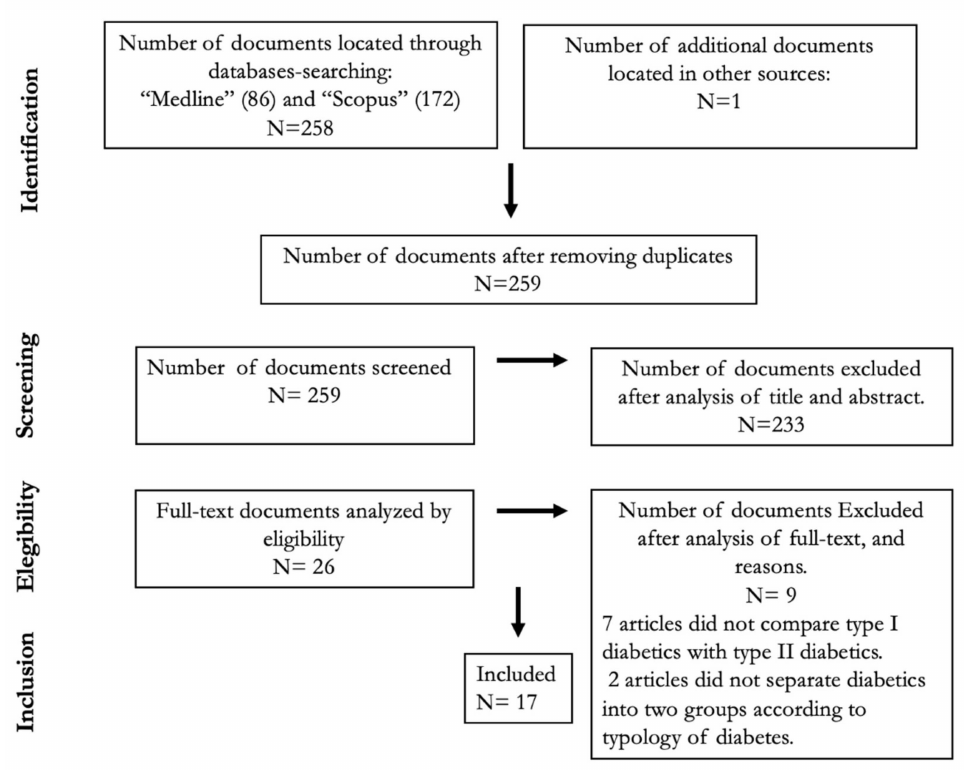
Figure 1. Systematic review